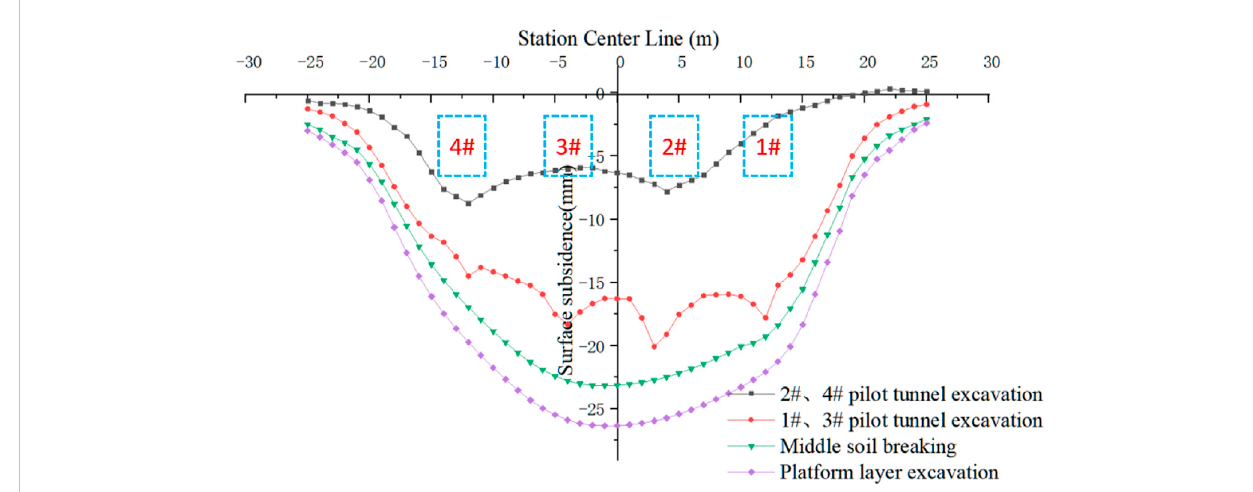
FIGURE 10 Surface subsidence curve of the entire construction process.